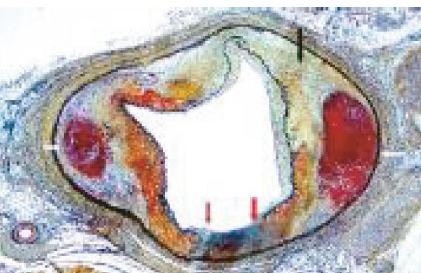
Figure 24: Segmental arterial mediolysis reparative phase evolved to FMD with intramural hematomas. The black arrow points to a large zone of granulation tissue expanding the tear space and reoccupying areas of lost media. The white arrows point to two hematomas generated in the granulation tissue. The red arrows point to two foci of transmedial granulation tissue bordering a central medial island. Movat stain × 25 (adapted with permission from Cardiovascular Pathology 18(6) copyright 2009, Elsevier